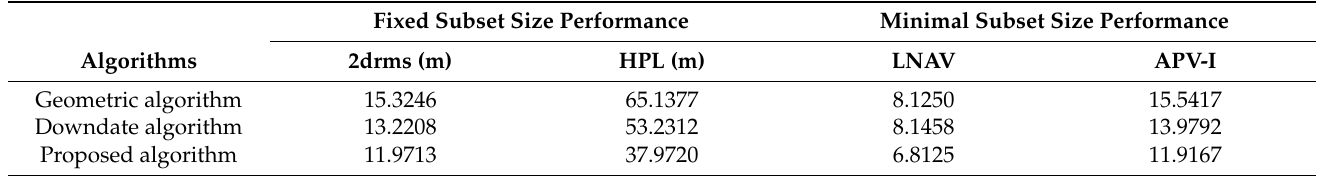
Table 6. Performance comparison among the three algorithms in high latitudes. Fixed Subset Size Performance Minimal Subset Size